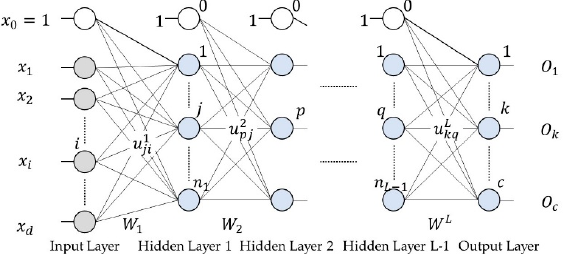
Figure 7. Structure of the DNN model.